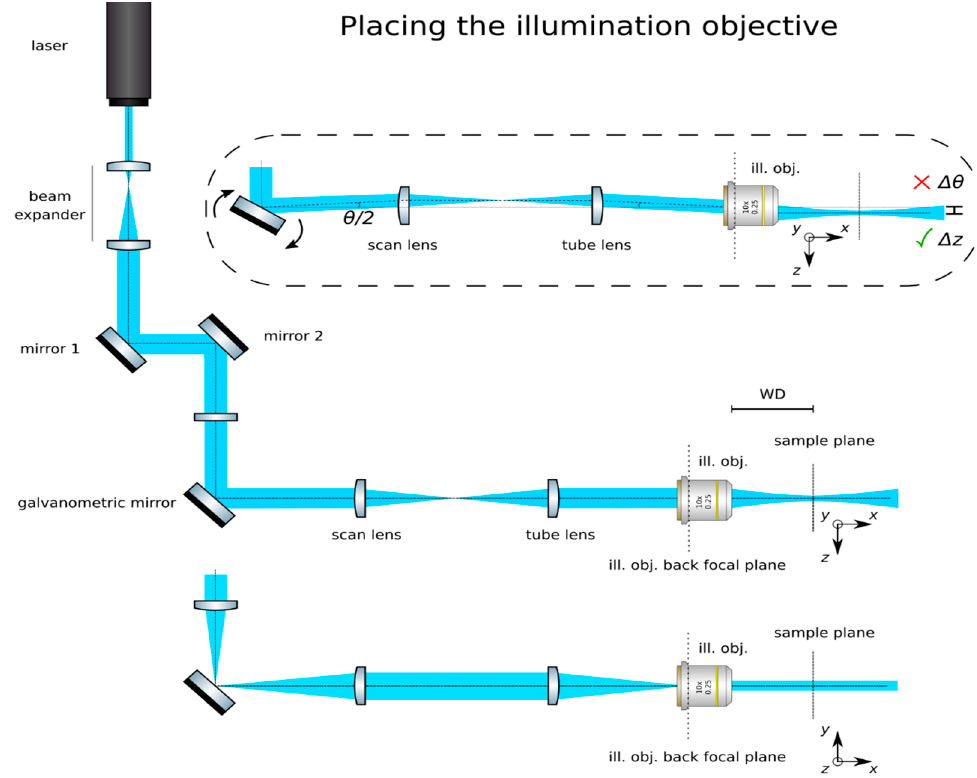
Figure 7. Placing the illumination objective. If placed correctly, a collimated beam should be achieved along the y -axis, while strongly converging into a light sheet along the z -axis.